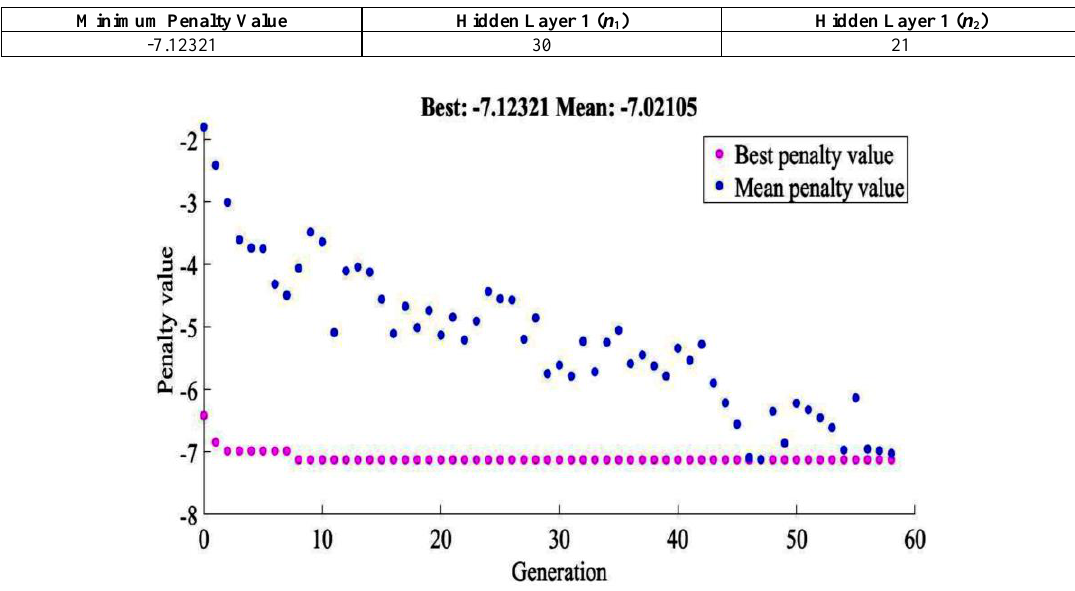
Table 3. Optimised result.